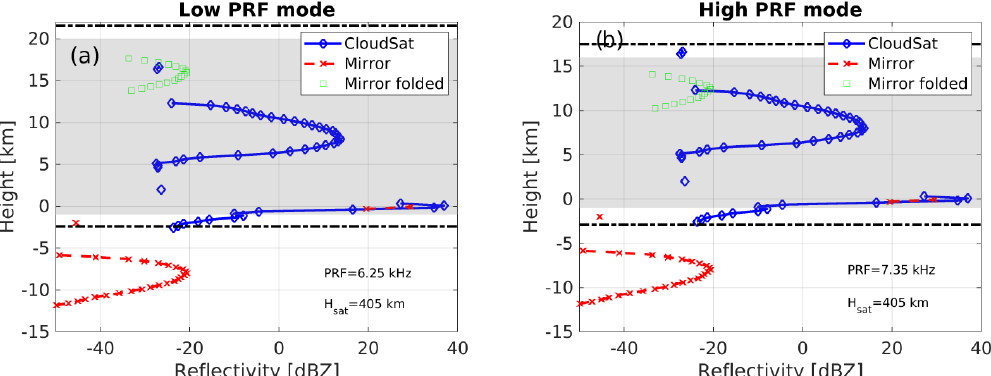
Figure 4. Example of how the mirror image is expected to fold for the low-PRF mode (a) and high-PRF mode (b) for the EarthCARE CPR in correspondence with the same CloudSat profile illustrated in Fig. 2b. The dot-dashed black lines delimit the folding ranges; the shaded grey region covers the EarthCARE sampling window for the two